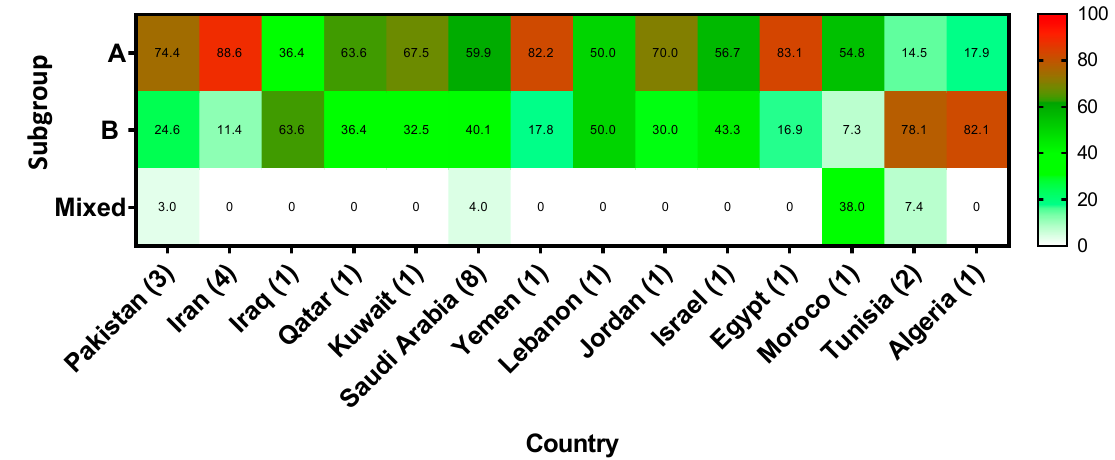
Figure 6. RSV subgroups (RSV A & RSV B) distribution in MENA region between 2001–2019. Microorganisms 2020 , 8 , x FOR PEER REVIEW